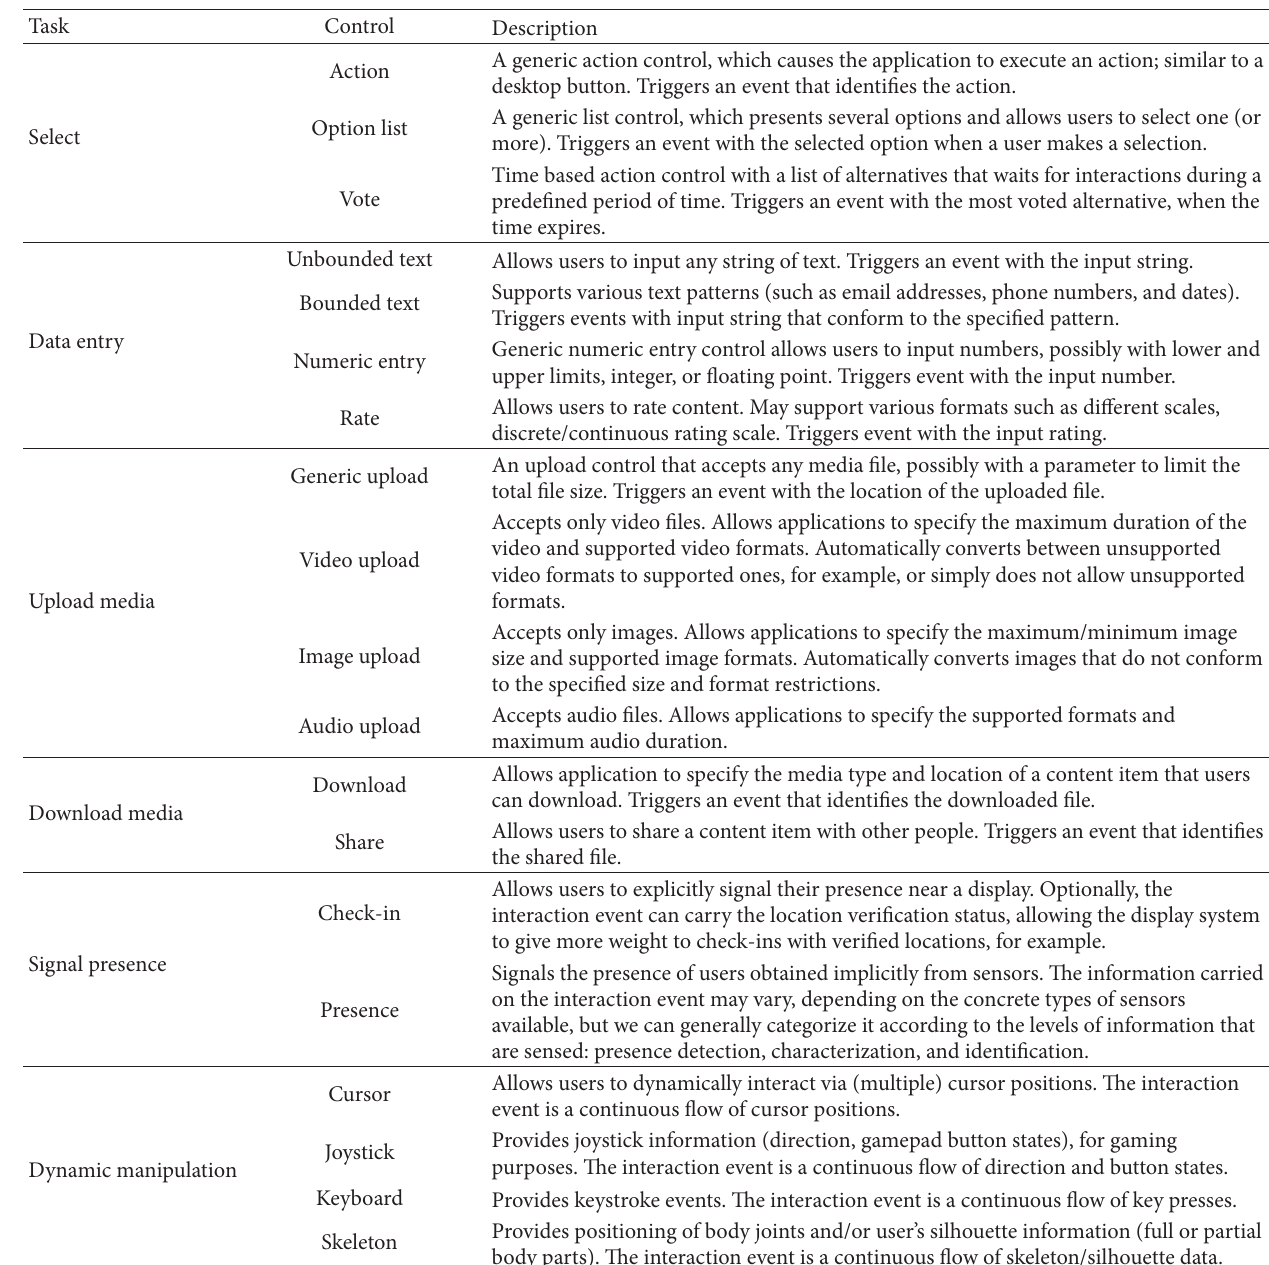
Table 6: List of possible controls for supporting the various interaction